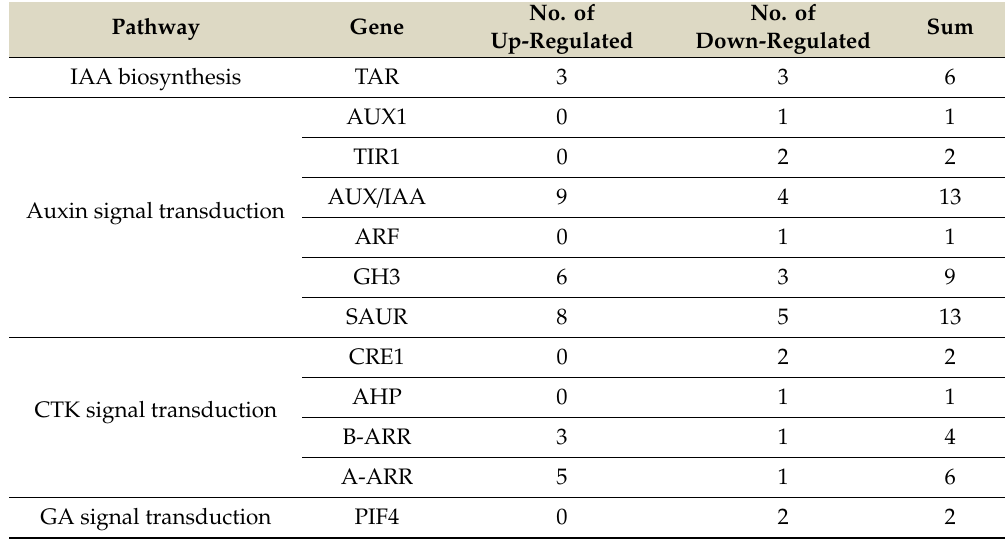
Table 6. Di ff erentially expressed genes of eight plant hormone synthesis and signal transduction. No. Pathway Gene